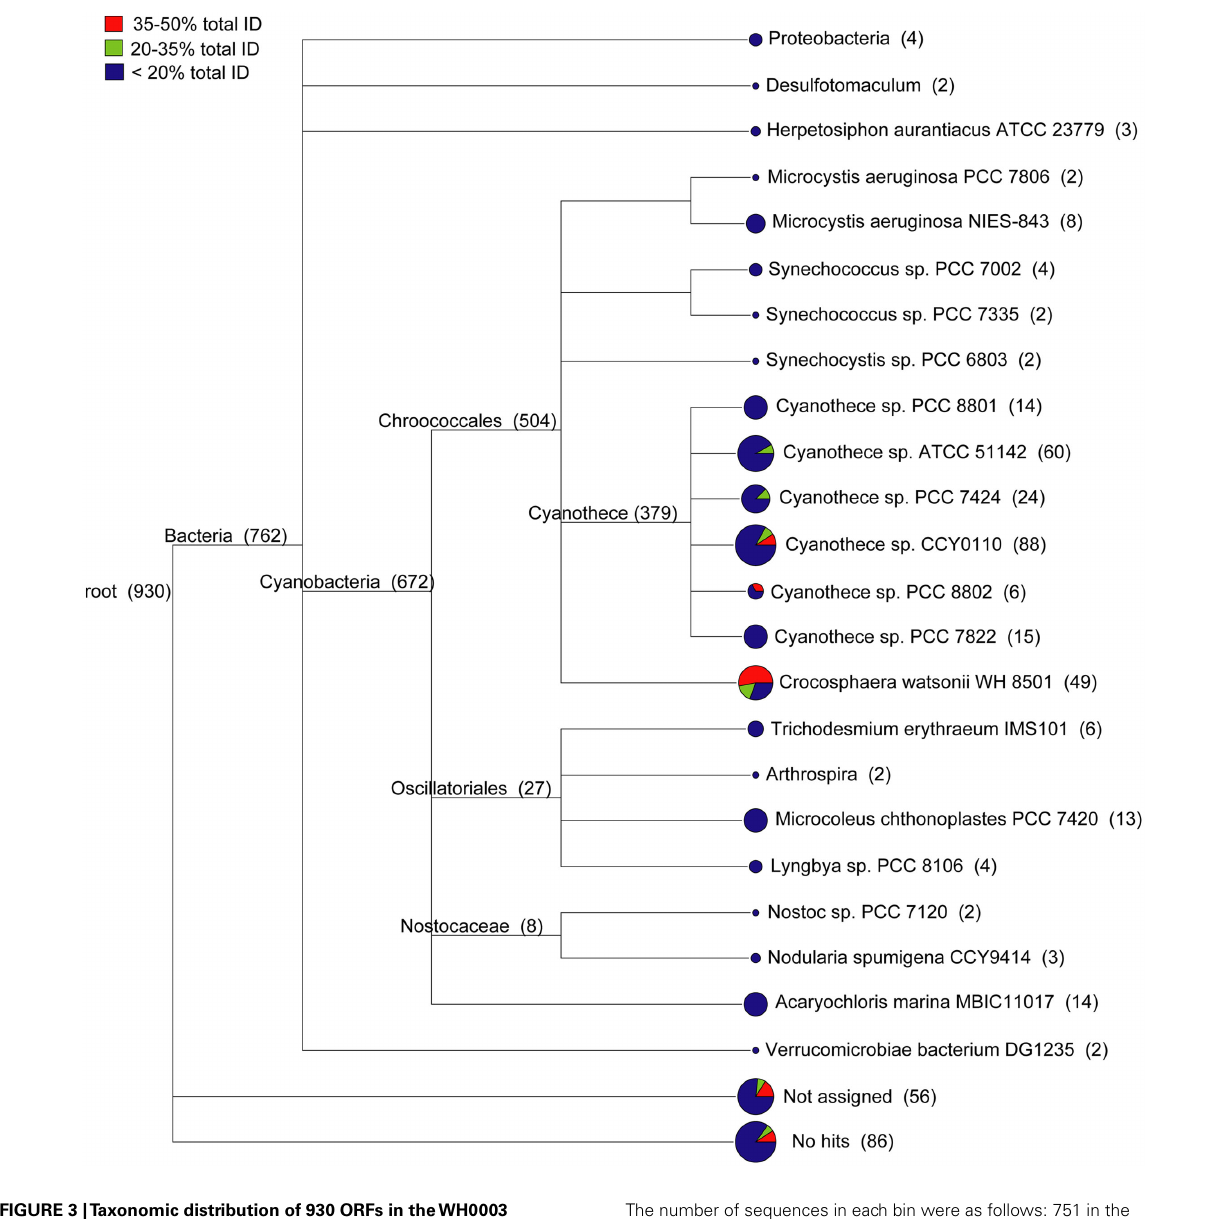
FIGURE 3 |Taxonomic distribution of 930 ORFs in theWH0003 genome that show little or no sequence similarity to theWH8501 genome. WH0003 sequences were binned according to the level of sequence similarity to theWH8501 genome across the entire ORF.